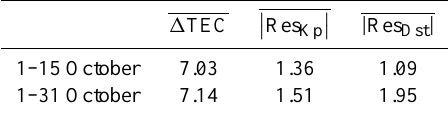
Table 1. Mean values of 1 TEC and residuals during the period be- fore the Hector Mine earthquake and during the month of Octo- ber